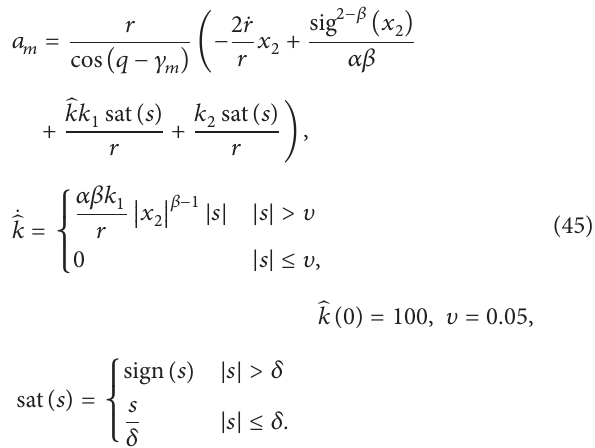
Figure 19: LOS angle (Case